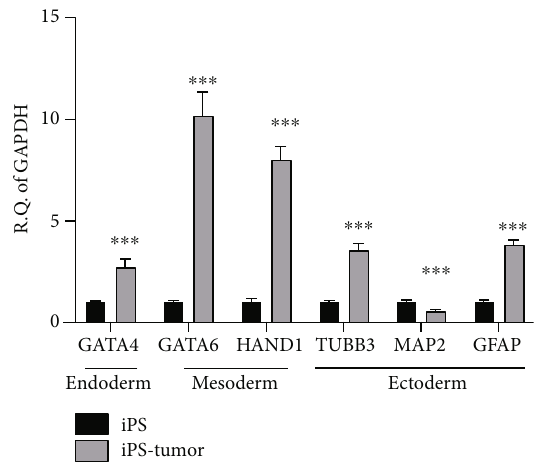
Figure 2: Gene expressions of iPSC-derived teratoma compared to iPSC. qPCR showed teratoma expressing more gene expressions of GATA4 (endoderm), HAND1 , GATA6 (mesoderm), TUBB3 , MAP2 , and GFAP (ectoderm) than iPSC. Statistical analyses between both groups were calculated with Mann – Whitney U test. ∗∗∗ p < 0 : 001 .